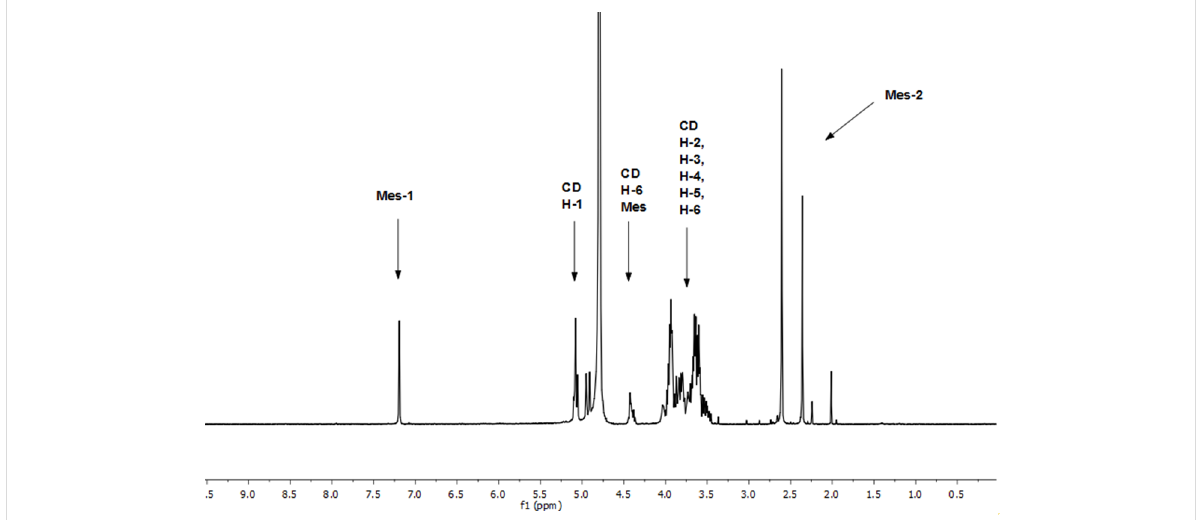
Figure 5: 1 H NMR spectrum of the AC regioisomer 8c as a mixture of pseudoenantiomers prepared through reaction 6 (D 2 O, 600 MHz).